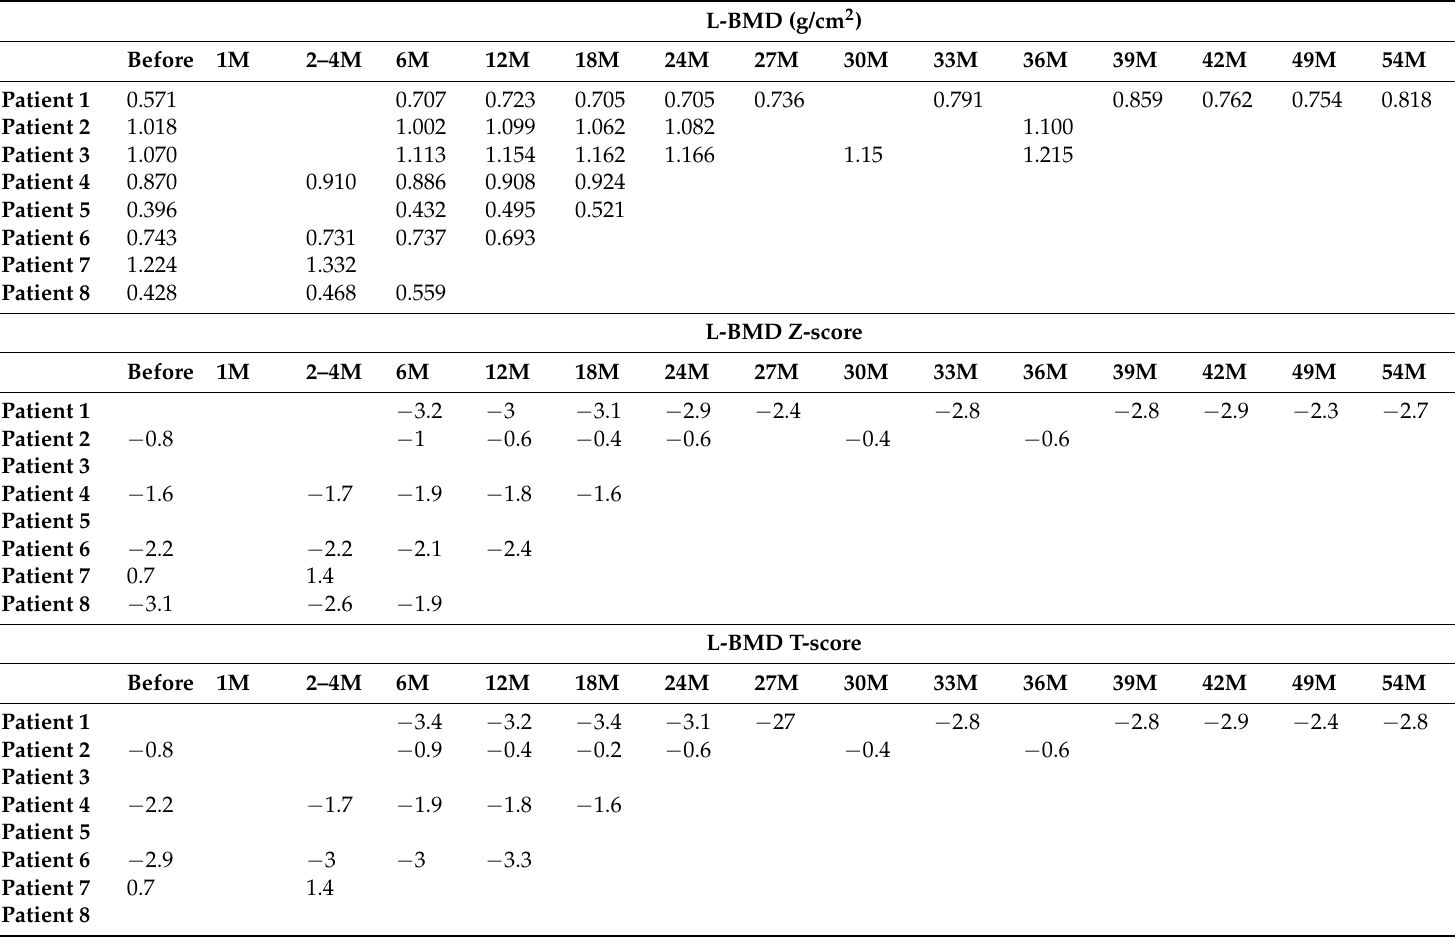
Table 3. Patient bone mineral density across observation periods for each